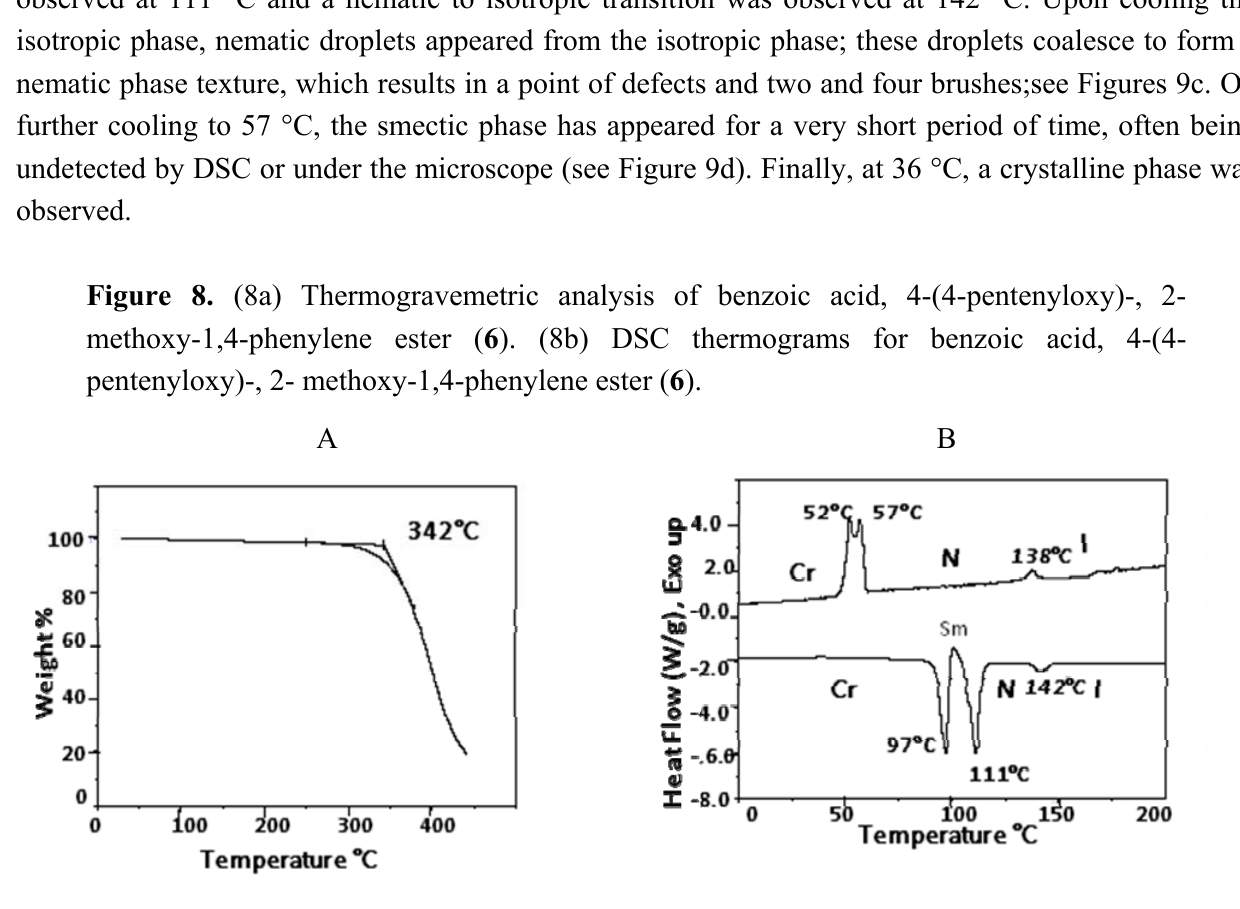
Table 3. Phase transition temperatures and enthalpy changes compound 6